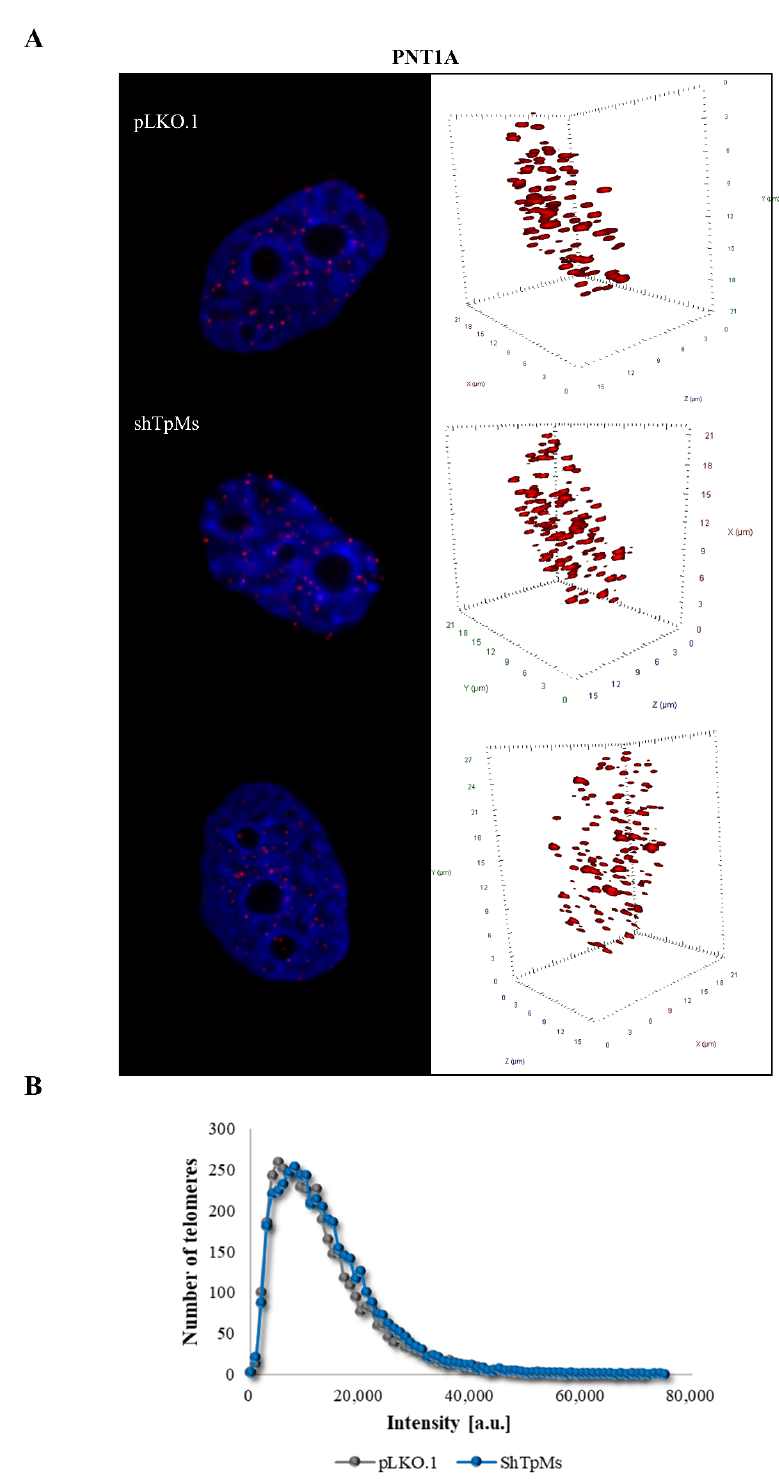
Figure 4. Number of telomere signals and aggregates in TpMs-depleted PNT1A cells. ( A ) Represen- tative nuclei, counterstained with DAPI (4 (cid:48) ,6-diamidino-2-phenylindole) (blue), where Cy-3 labelled telomeres appear as red dots. ( B ) A telomere intensity histogram showing distribution of signal intensities in PNT1A cells depleted of TpMs with respect to control. Loss of TpMs in PNT1A cells did not show significant differences in the number of telomere signals and aggregates compared with the control cells (pLKO.1). [a.u.] = arbitrary units. Abscissa = intensity [a.u]. ordinate = number of telomere